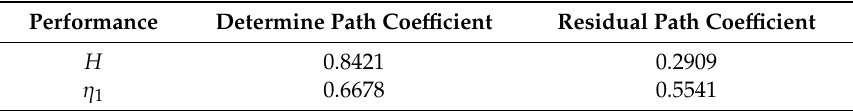
Table 3. Residual path coe ffi cient between impeller geometric parameters and performance.